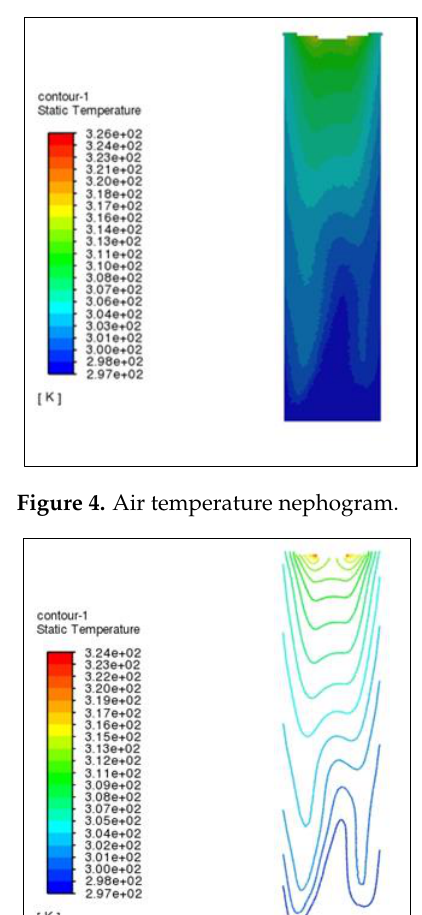
Figure 6. Average air temperature at different cross section heights.